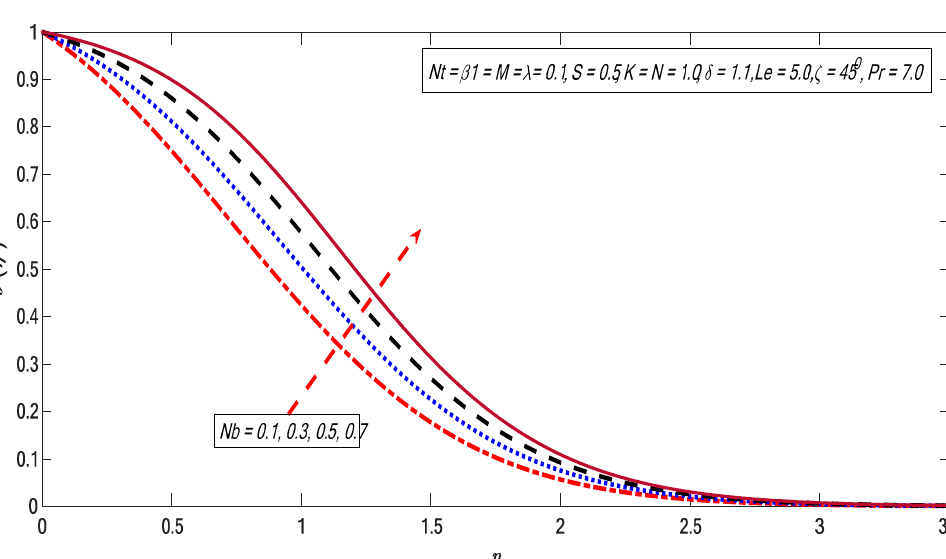
Figure 10. Variations in temperature profile for several values of 𝑀 .